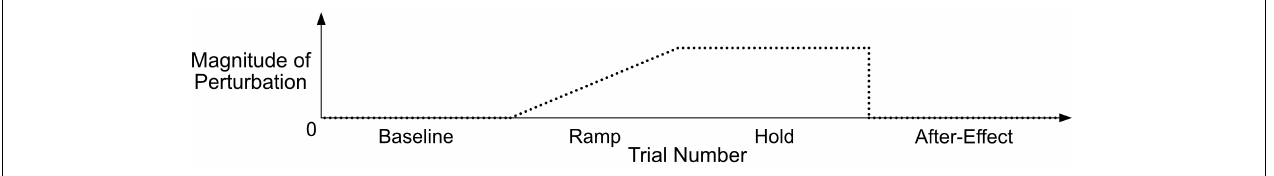
FIGURE 1 | A schematic of a typical sensorimotor adaptation paradigm with four phases. During the baseline phase, participants receive normal auditory feedback (magnitude of perturbation = 0). The perturbation is gradually increased from 0 to its maximum value during the ramp phase. The maximum perturbation is held constant during the hold phase. Auditory feedback immediately returns to normal during the after-effect